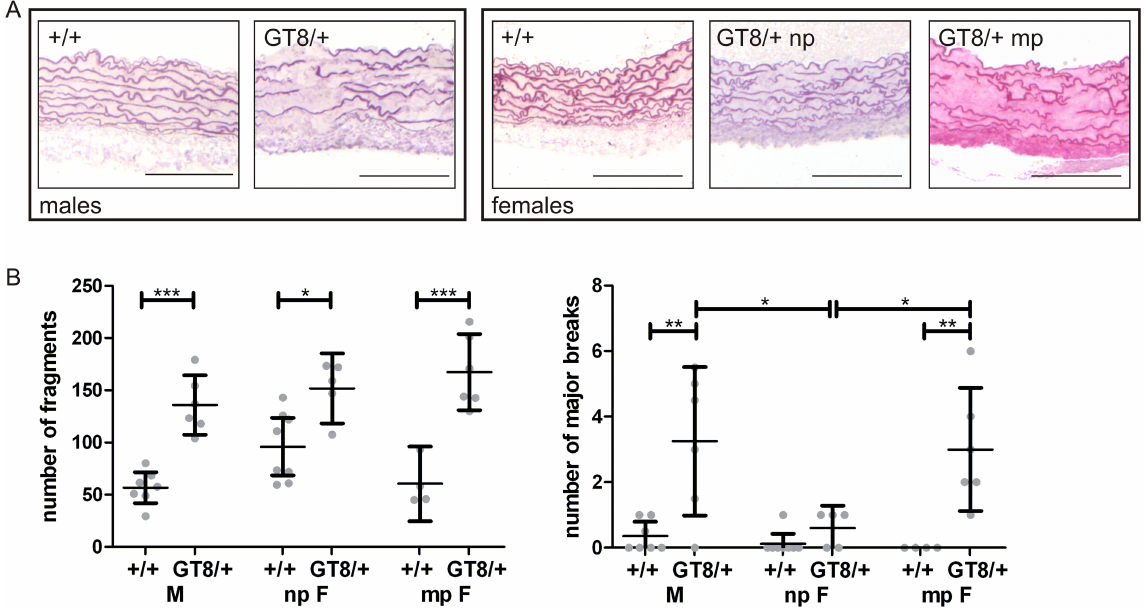
Fig 3. Aortic root morphology in wild-type and heterozygous GT-8/+ mice at the age of 8 months. A. The aortic elastic lamellaeof GT-8/+ mice show clear fragmentation compared to the wild-typecontrols. Major breaks spanning at least 3 consecutive layers of elastic lamellaecan be found in male and multiparousfemale GT-8/+ mice. Scale bars = 100 μ m. B. At the age of 8 months, GT-8/+ male mice show significantly more fragmentation of the aortic elastic lamellae(left graph) and an increasednumberof major breaks (right graph) compared to wild-type littermates. Similarly, nulliparous and multiparous female GT-8/+ mice both show significantly more fragmentation of the aortic elastic lamellaecomparedto wild-type(left graph). The number of major breaks in the aortic root of multiparousGT-8/+ female mice is, however,significantly higher than in nulliparous GT-8/+ female mice and multiparous wild-typefemale mice (right graph). Each symbol represents a singleanimal. Means with 95% confidenceintervals are shown. F: female; M: male; np: nulliparous; mp: multiparous; p-values: * < 0.05, ** < 0.005, *** < 0.001.